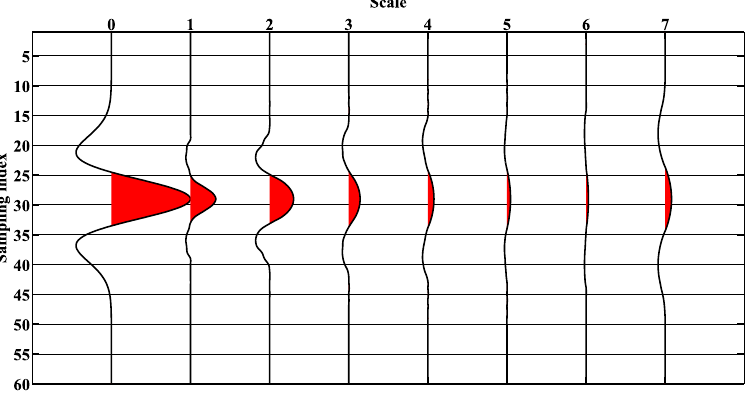
Figure 1. Multi-scale morphological decomposition of a Ricker